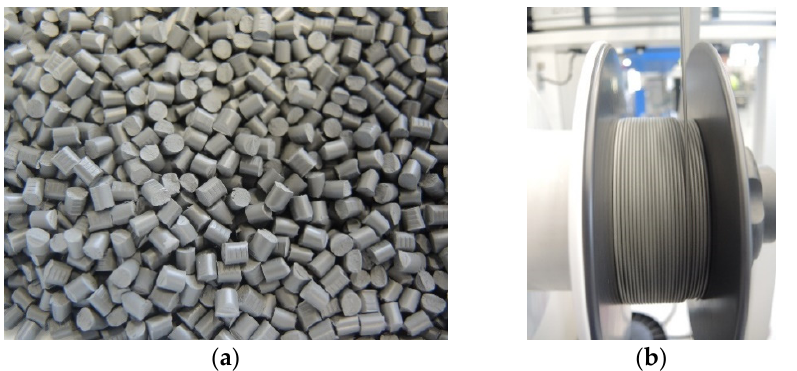
Figure 3. ( a ) Homogeneous feedstock granulated with a solid loading of 63 vol.%, ( b ) Continuous spooling of the 1.75 mm NiTi filament.